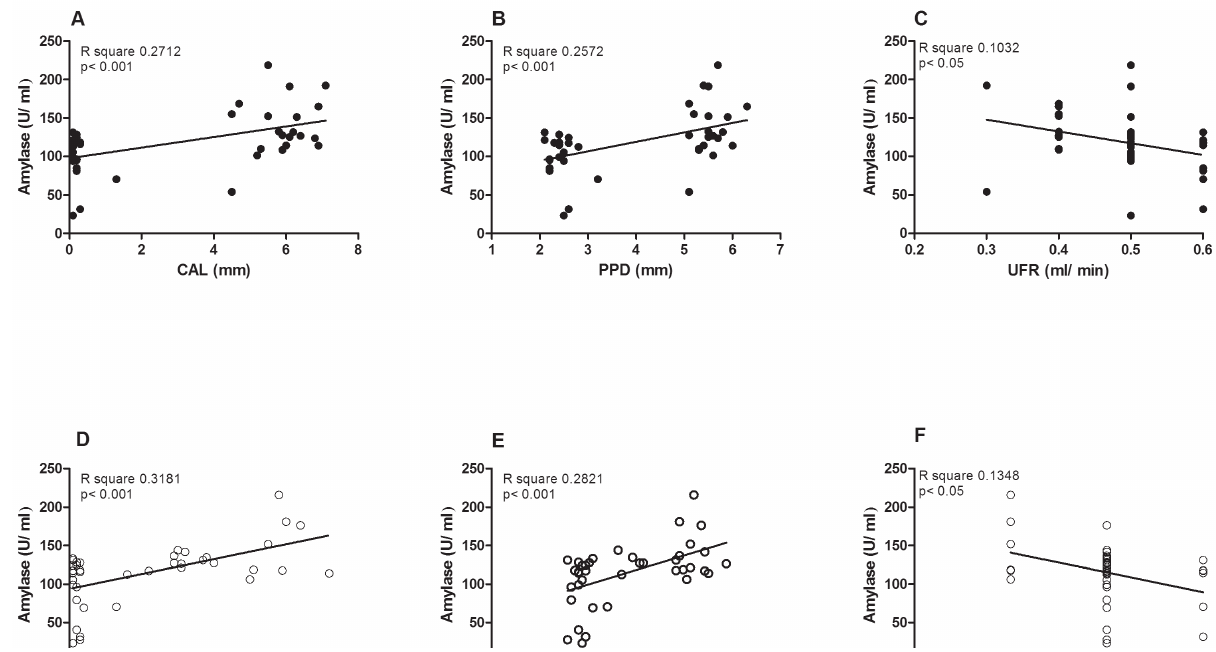
Figure 6- Pearson’s correlation analysis between amylase and clinical attachment level (CAL) (A and D), probing pocket depth (PPD) (B and E) and unstimulated flow rate (UFR) (C and F) in aggressive periodontitis (AgP) (upper panel) and chronic periodontitis (CP) (lower panel) groups